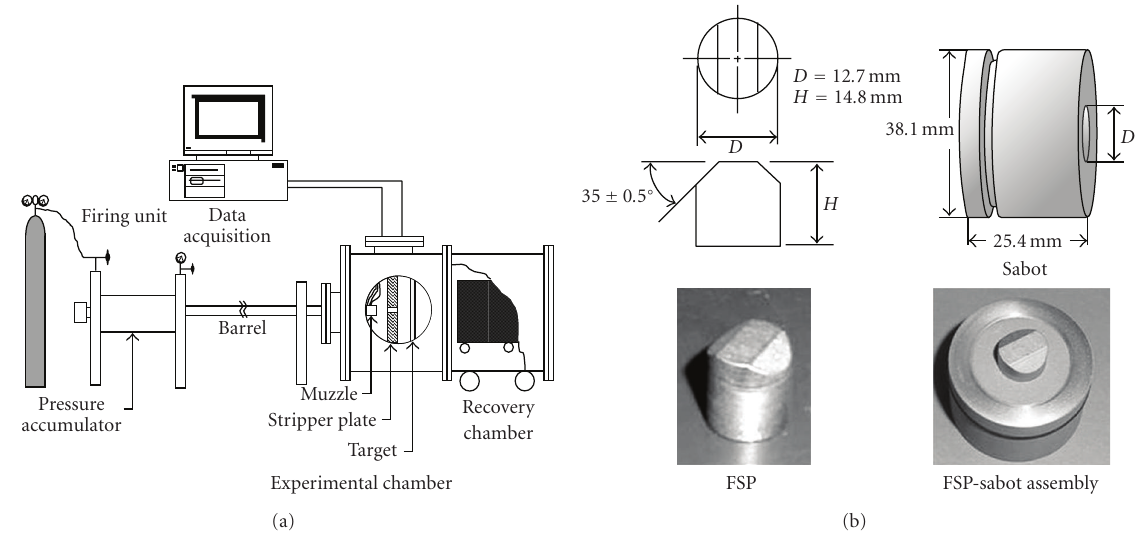
Figure 1: (a) Experimental setup for gas gun. (b) Projectile and sabot.